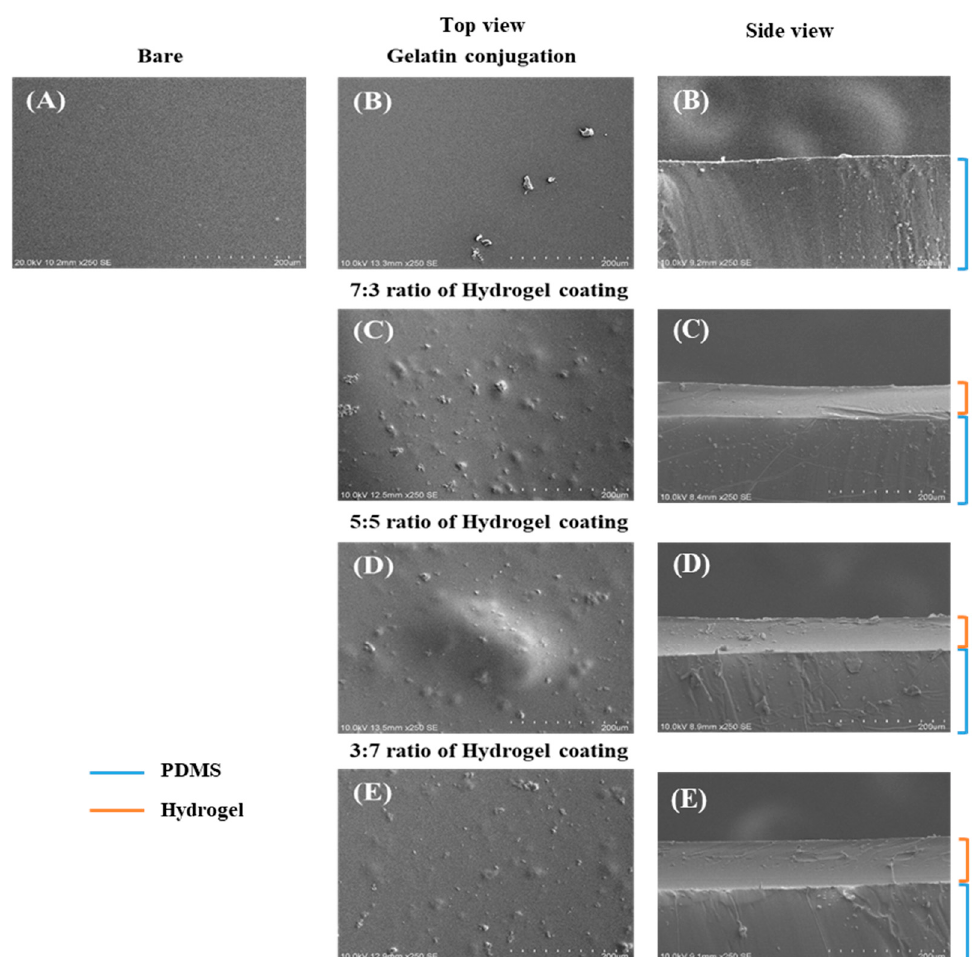
Figure 4. Top- and side-view scanning electron microscopy (SEM) images of the modified poly(dimethylsiloxane) (PDMS) surface compared to the bare PDMS surface. ( A ) Bare PDMS; ( B ) Gelatin-conjugated PDMS and hydrogel-coated groups with CHO–HA/Gel–NH2 of ( C ) 7:3, ( D ) 5:5, and ( E ) 3:7.